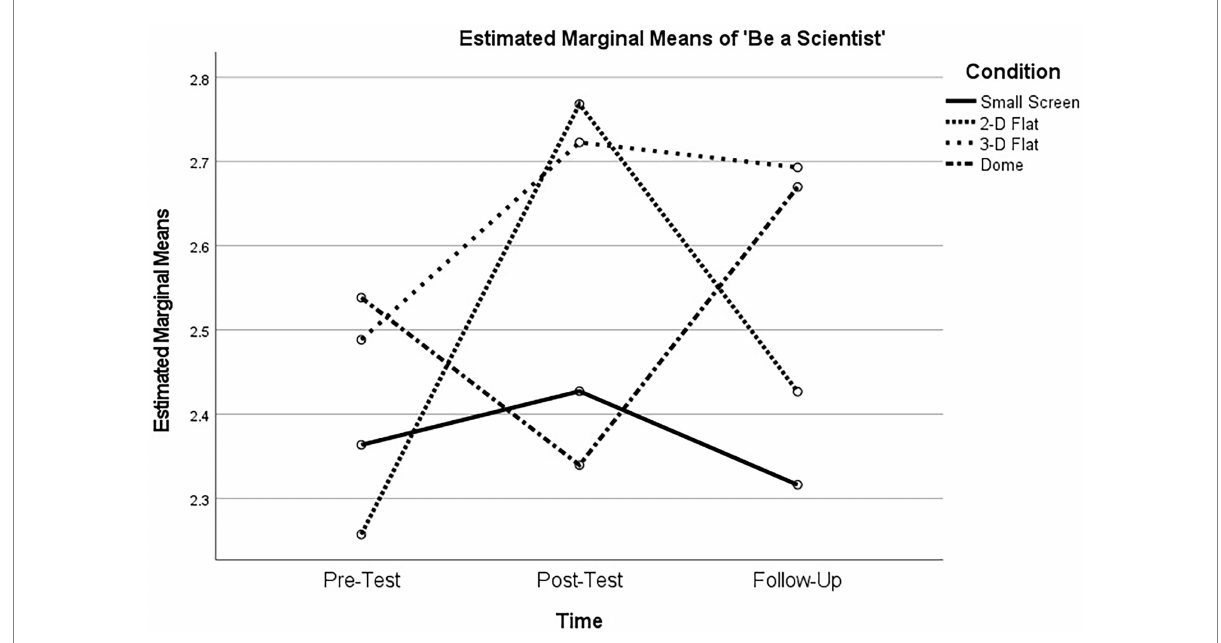
FIGURE 8 “Be a Scientist when I grow up” performance for the four groups.